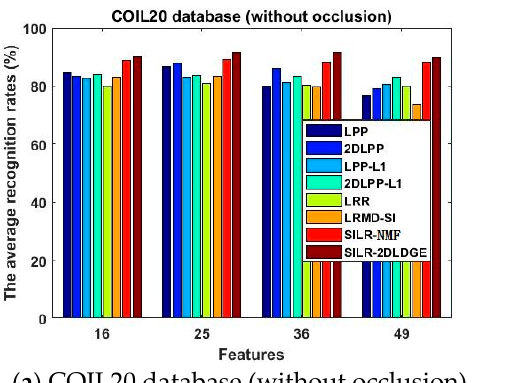
Figure 4. The average recognition rates (%) of the eight algorithms in the ORL database varies with the dimension.